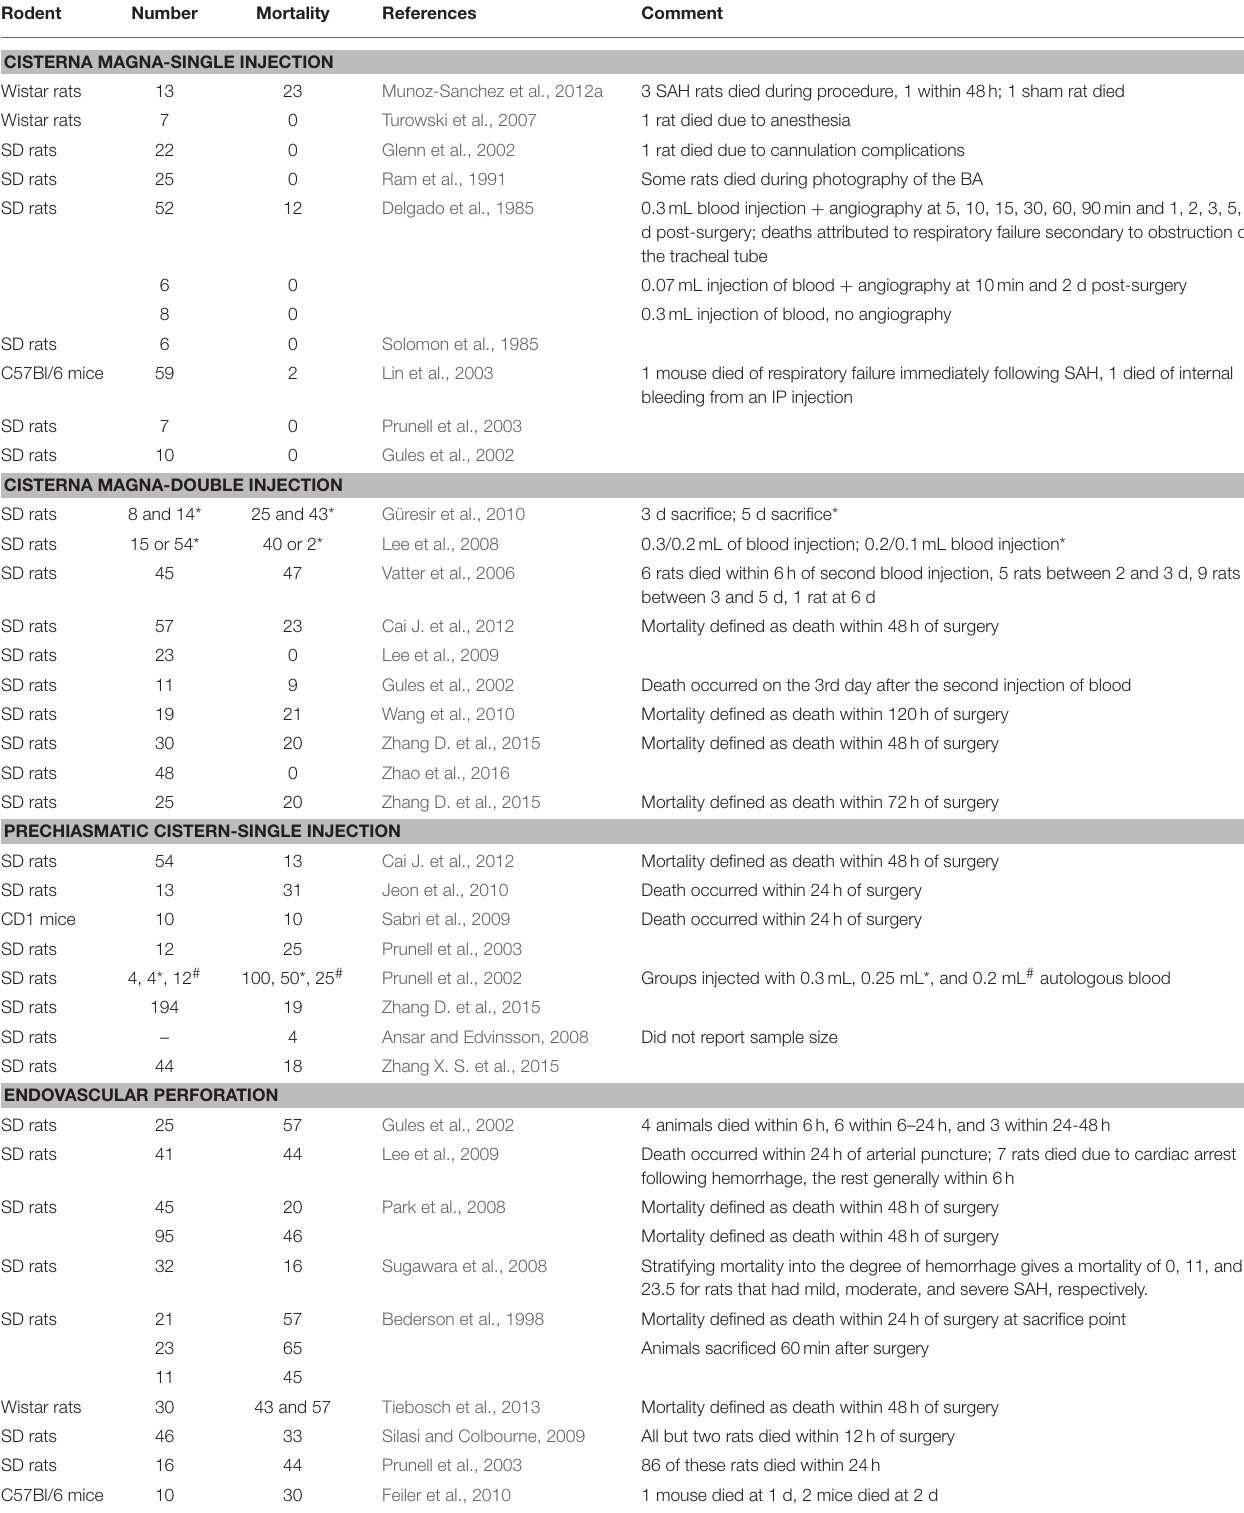
TABLE 6 | Summary of mortality itemized by the model used for SAH induction in published studies that used various strains of mice or rats. Rodent Number